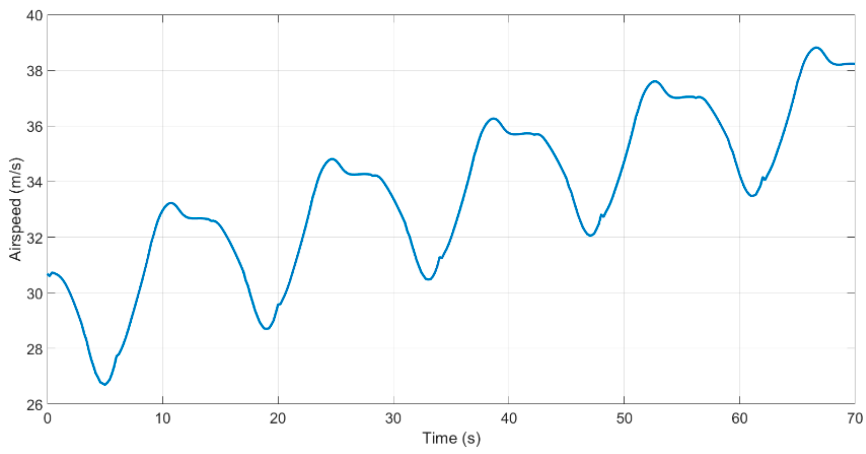
Figure 13. The airspeed change during the dynamic soaring.